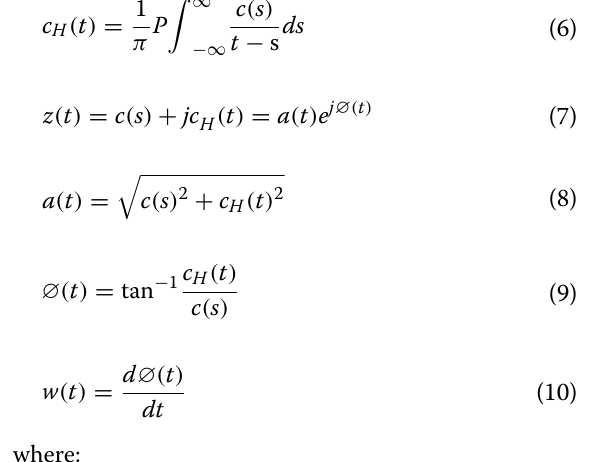
together. Quadratic penalty terms and Lagrangian mul -